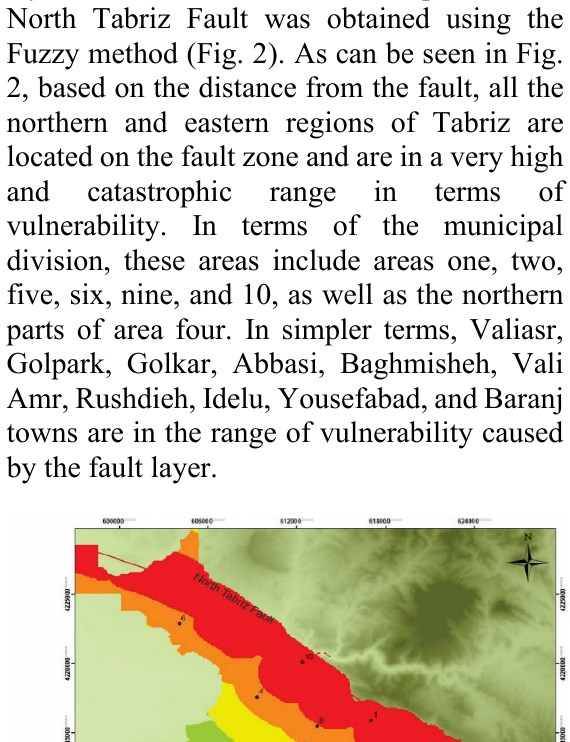
Fig. 3. Seismic vulnerability map of Tabriz city based on slope